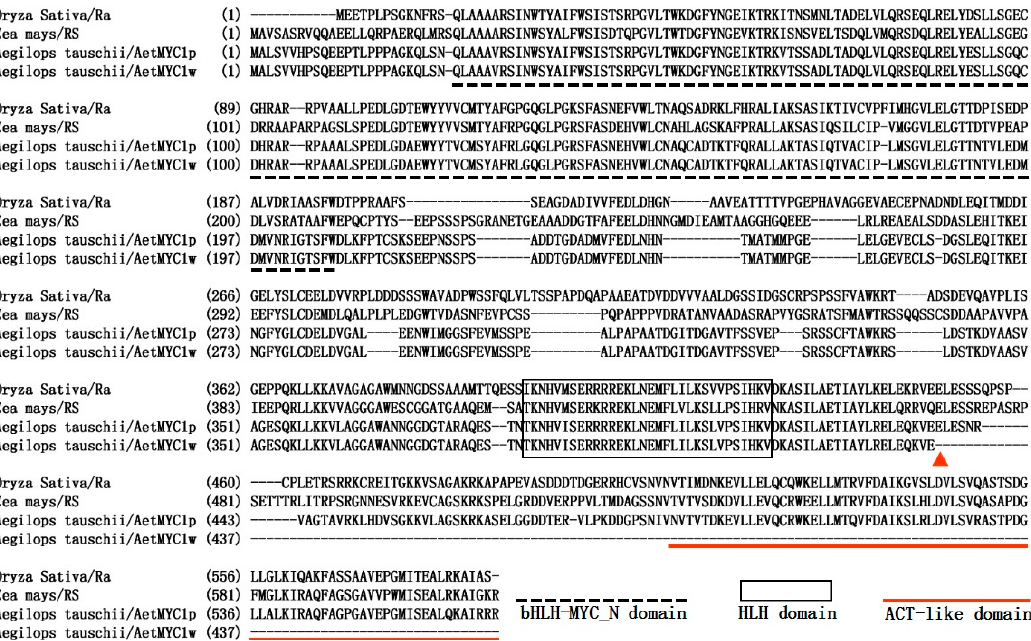
Figure 2. Amino acid sequence alignment of bHLH transcription factors AetMYC1, RS and Ra. The black dotted lines represent the conserved bHLH-MYC_N domain, the black rectangle represents the HLH domain, and the red dotted lines represent the ACT-like domain. The red triangle represents the location of the stop codon.